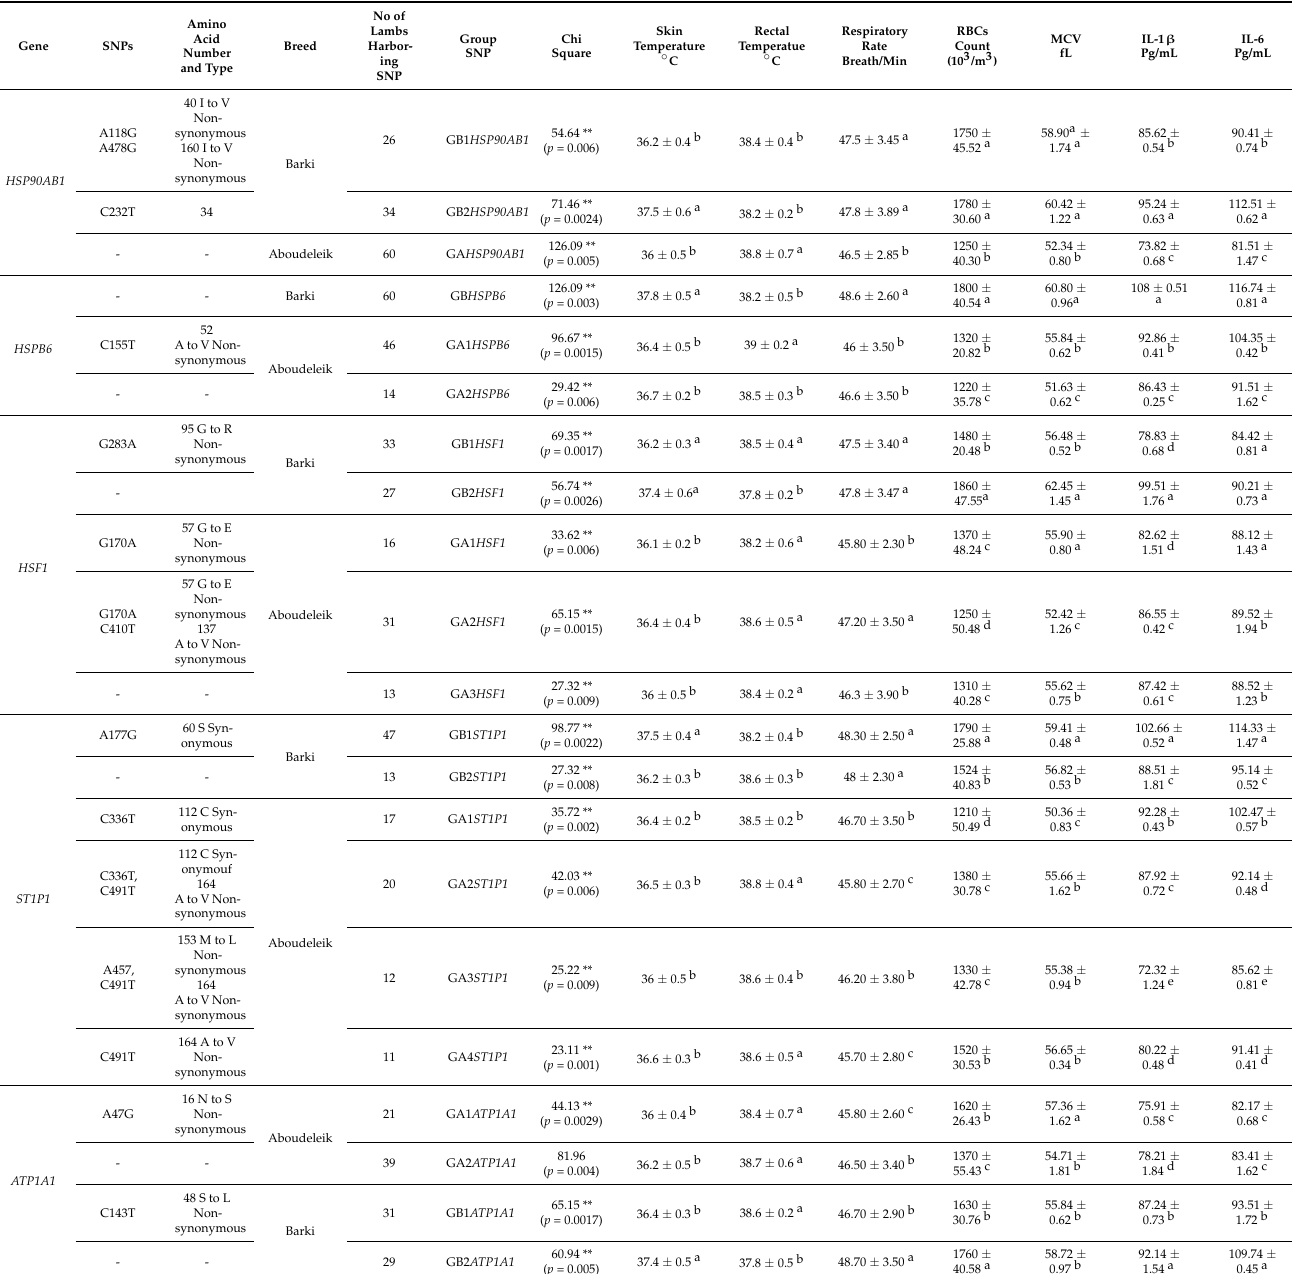
Table 5. Distribution of SNPs, type of mutation in heat tolerance genes and their association with physico-chemical parameters in Barki and Aboudeleik